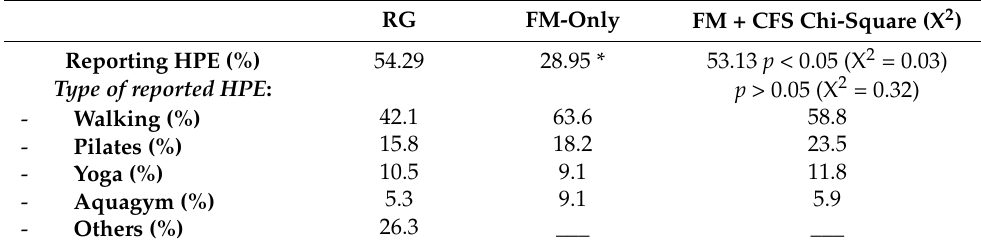
Table 2. Percentage of subjects reporting Habitual Physical